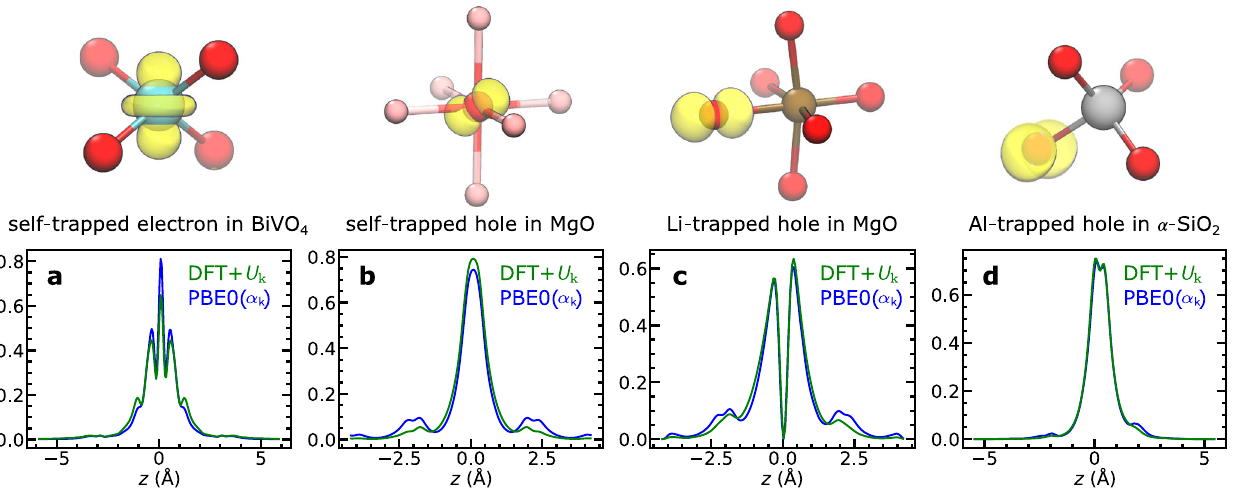
Fig. 4 Polaron electron density. Electron densities obtained with DFT + U k and PBE0( α k ) functionals for the self-trapped electron in BiVO 4 , the self-trapped hole in MgO, Li-trapped hole in MgO, and the Al-trapped hole in α -SiO 2 . The defect density is integrated over xy -planes. On top, isodensity surfaces at 5% of their maximum (Bi in orange, V in cyan, O in red, Mg in pink, Li in brown, Si in blue, Al in gray).